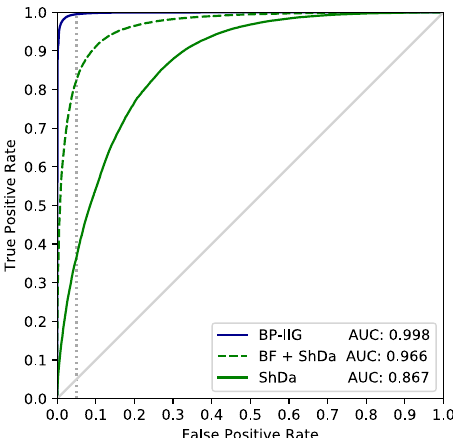
Fig. 8 Receiving operator characteristic (ROC) curves with area under the curve (AUC) score for the node pair classi fi cation task for k = 2. The performance of a random classi fi er is shown in solid gray. Even for their task, our method (blue line) vastly outperforms both ShDa (solid green line) and its improved version ShDa + BF (dashed green line). For a false positive rate of 0.05, our method achieves a true positive rate of 0.99 vs. 0.36 for ShDa and 0.82 for ShDa + BF (vertical dotted gray line). As shown in Supplementary Fig. 7, both ShDa and ShDa + BF perform poorly when it comes to correctly identifying a